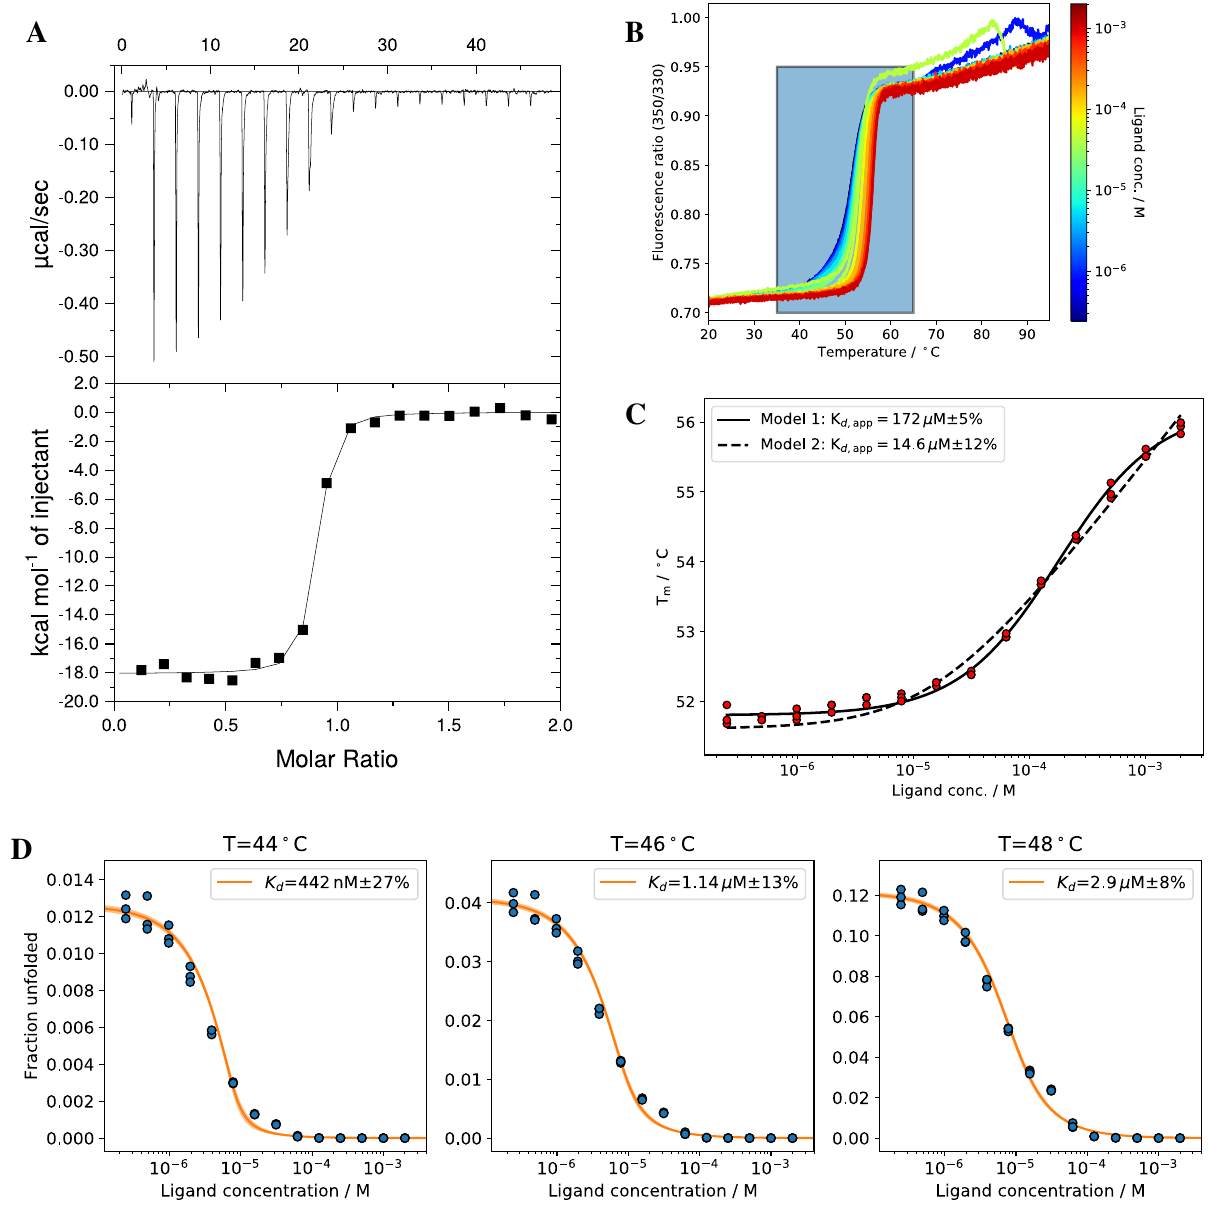
Figure 3. ( A ) The Buffer subtracted ITC of EG1/ADPR yields K d = 16 ± 4 nM (3 measurements) ( B ) nDSF signal (Ratio) for EG1/ADPR binding study with a protein concentration of 8 µM and ligand concentrations between 2 mM and 24 nM (14 dilutions). The region in the colored box was used for isothermal analysis (shown in D ). ( C ) Melting temperature analysis with two different models yields apparent K d,app values. ( D ) Isothermal analysis of nDSF data for ∆ C p = 0 at three selected temperatures. The same analysis for a fitted ∆ C p (cf. Table 1) is shown in Supplementary Information